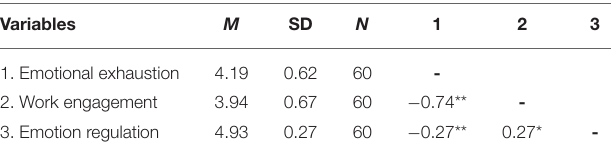
TABLE 1 | Descriptive statistics, and correlations coefficients for the study